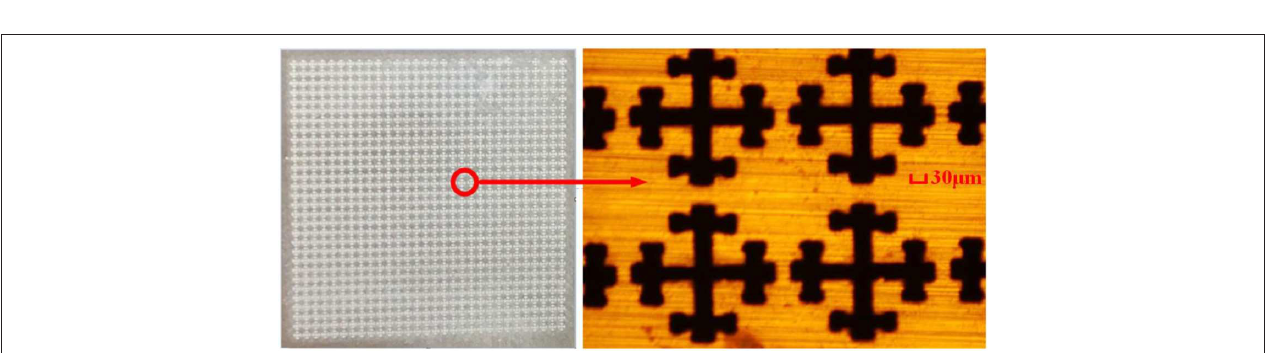
FIGURE 5 | Photography of the fabricated structure and a local enlarged microscopic image.